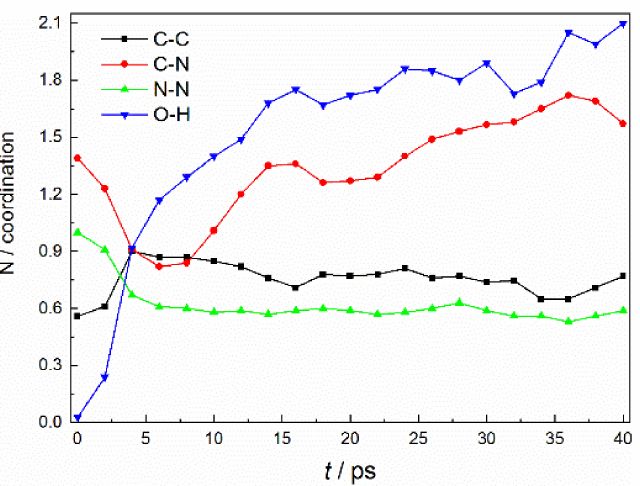
Figure 9. Amount of first coordination numbers of different atom pairs in the HMX(100)/HTPB